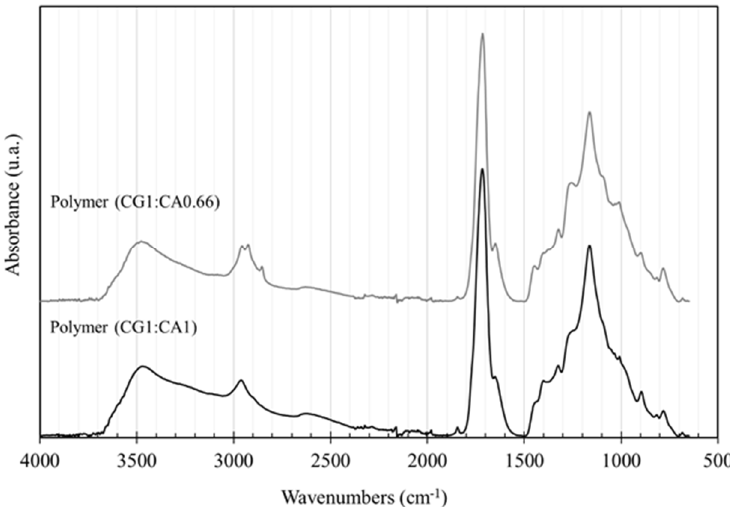
Figure 5. FT-IR spectra of CG1:CA0.66 and CG1:CA1 formulation cured at 200 °C for 13 min.